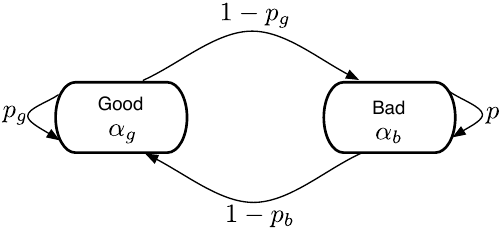
Figure 6. Gilbert-Elliott burst link